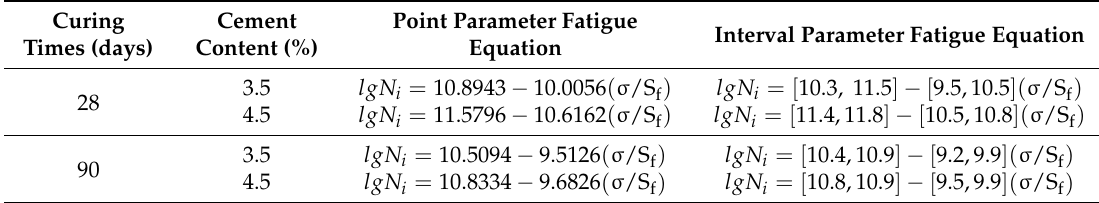
Table 11. Standardization fatigue prediction model for cement content of 3.5% and